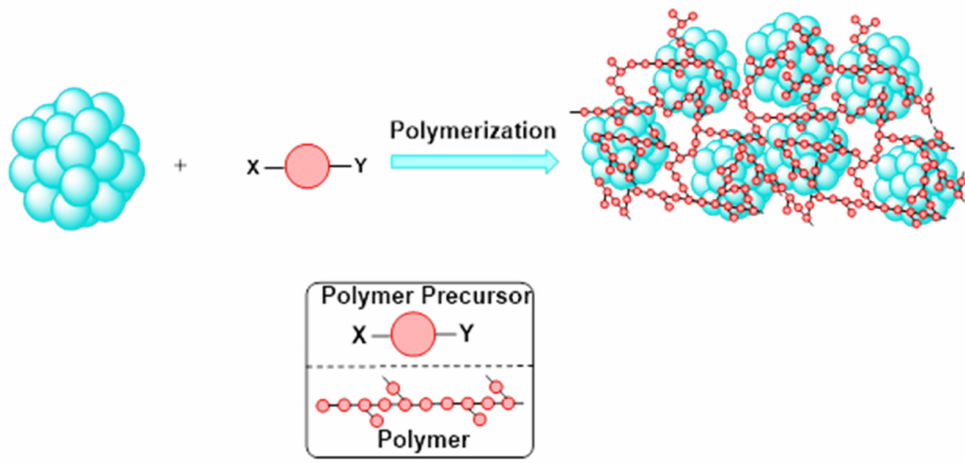
Figure 4. Schematic representation of phase transfer through polymer-based systems [2].